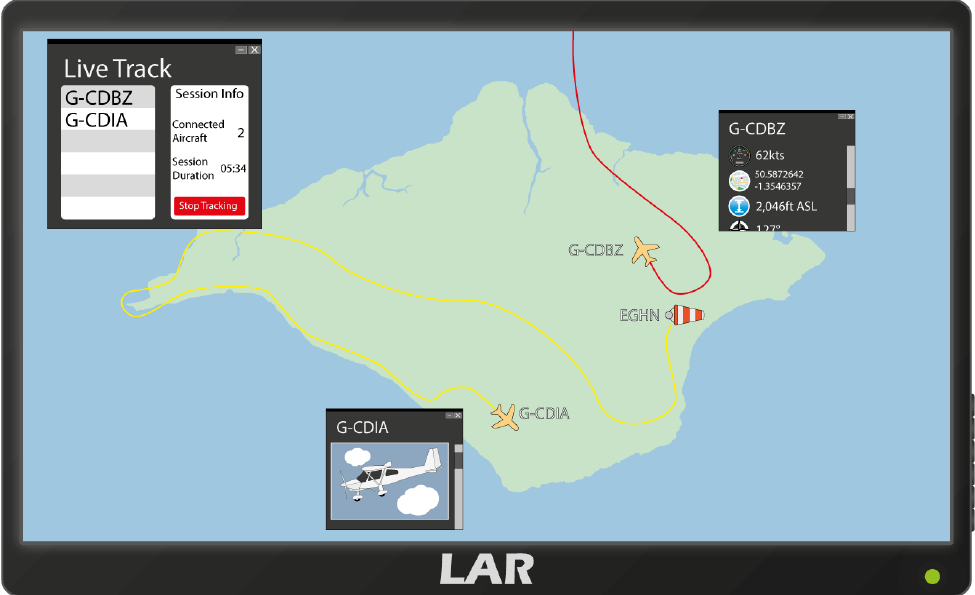
Figure 7. Low-fidelity prototype for live aircraft tracking on the desktop